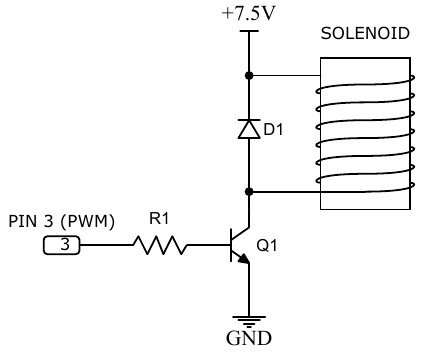
Figure 4. Power amplifier circuit. The PIN 3 of the Arduino Uno generates a PWM signal that drives the transistor Q1 into either ‘on’ or ‘off’, like a switch, thus controlling the current that flows through the solenoid coil accordingly. The components used are a resistance of R1 = 580 Ω , a diode D1 with a forward voltage drop of 450 mV and a forward current of 1 A, and transistor Q1 (code NTD4858N 25 V 73